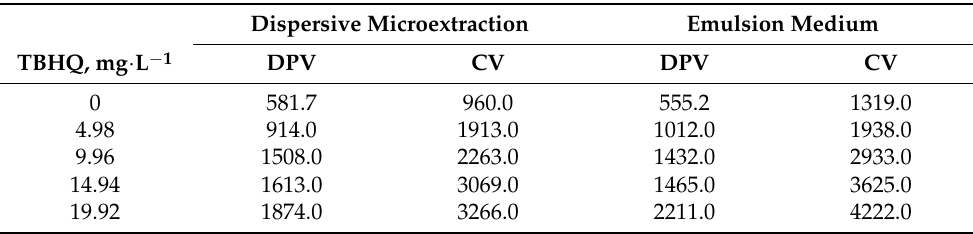
Table 3. Intensity peaks (A) for TBHQ quantification in emulsion medium and dispersive microex-